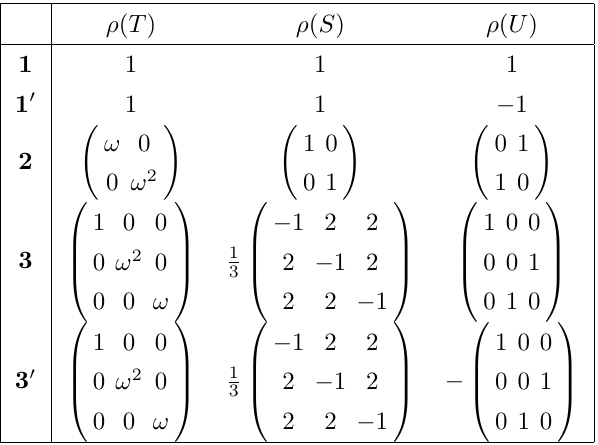
Table 5 . In the basis used, the representation matrices for T , S and U , with ω = e 2 πi/ 3